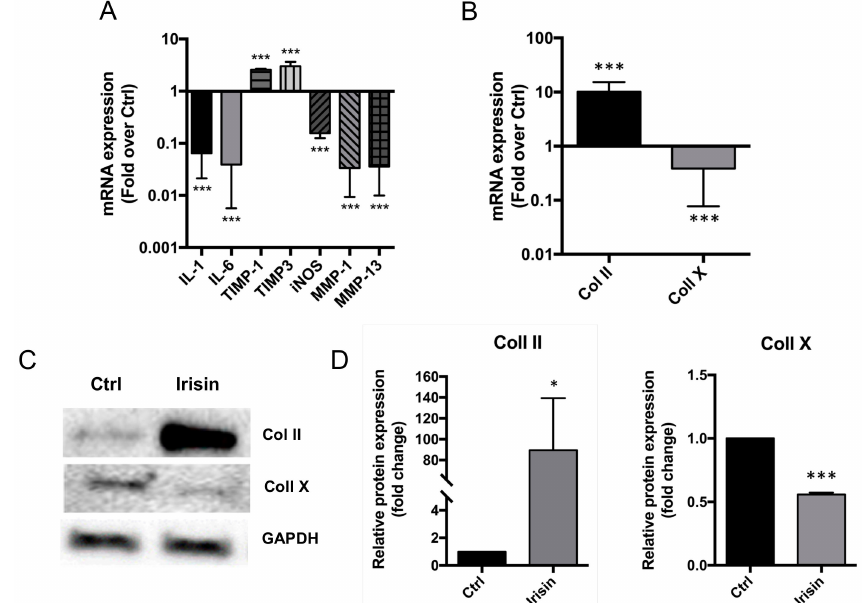
Figure 3. Irisin restores extracellular matrix (ECM) composition. ( A ) Irisin treatment significantly decreased IL-1, IL-6, iNOS, MMP-1 and MMP-13 gene expression, while increasing TIMP-1 and TIMP-3 mRNA levels. n = 3. ( B ) Type II collagen relative mRNA expression was significantly higher after 7 days of irisin exposure, as compared with the control group. Conversely, type X collagen relative mRNA expression was diminished upon irisin treatment compared to the control group. n = 3. ( C ) Western blot analysis confirmed the same trends, as type II collagen levels resulted higher whereas type X collagen levels were lower after irisin exposure at 7 days. n = 3. ( D ) Densitometric analysis of protein bands attested that these findings were statistically significant: type II collagen relative protein expression was increased (left chart), while type X collagen relative protein expression resulted to be lower at both intervals. Results were normalized based on GAPDH expression and calculated as fold change compared to the controls. * p = 0.037; *** p < 0.001. Ctrl, control group. IL, interleukin. TIMP, tissue inhibitor of metalloproteinases. iNOS, inducible nitric oxide synthase. MMP, matrix metalloproteinase. Coll II, collagen type II. Coll X, collagen type X. GAPDH, glyceraldehyde 3-phosphate